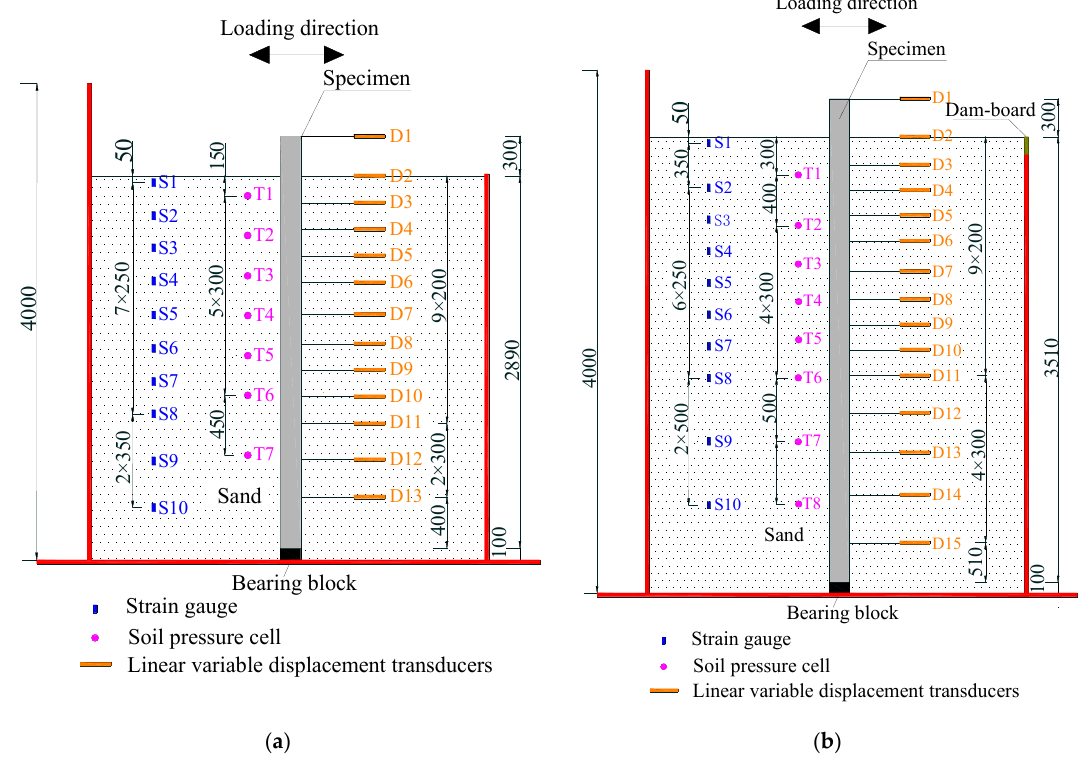
Figure 6. Sensor layouts of specimens (unit: mm). ( a ) CP-4. ( b ) CP-5.